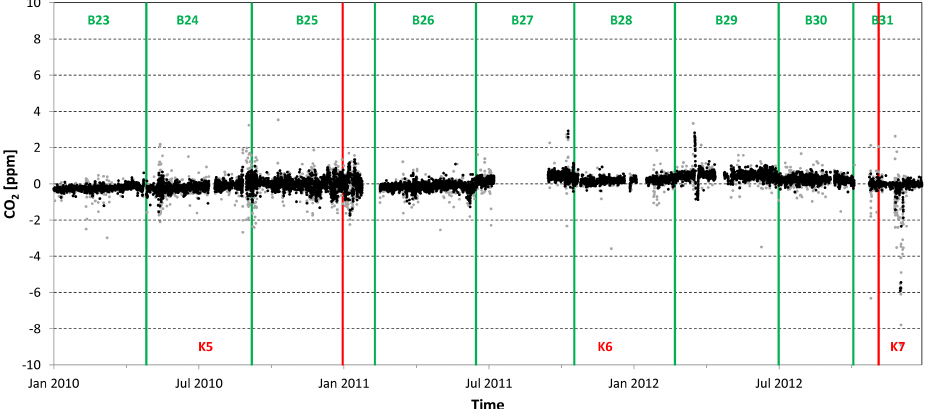
Figure 3. The difference of the CRDS – NDIR CO 2 measurements of all common hourly data points (grey points) and only during stable periods with a CO 2 change of less than 0.75ppmh − 1 (black points) against time. The green bars represent changes of the working gases of the NDIR system with the green number indicating the according cylinder and the red bars indicate the changes of the low span with the according number, also in red. The high span was not replaced throughout the entire